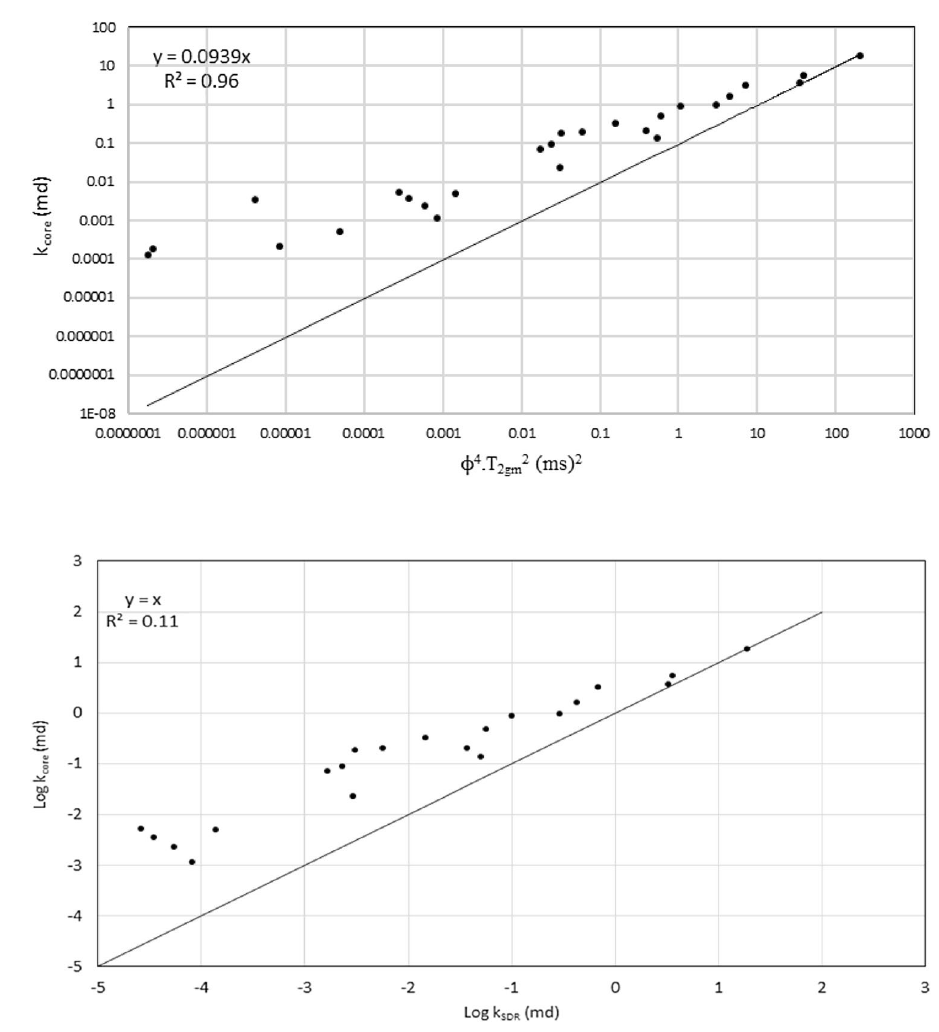
Fig. 8 A determination in SDR model ( m = 4, n = 2) (log–log scale)